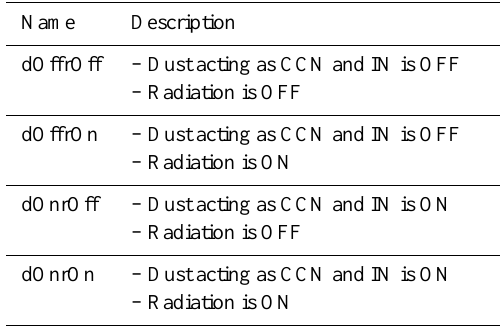
Table 2. Description and naming convention of the four experi-